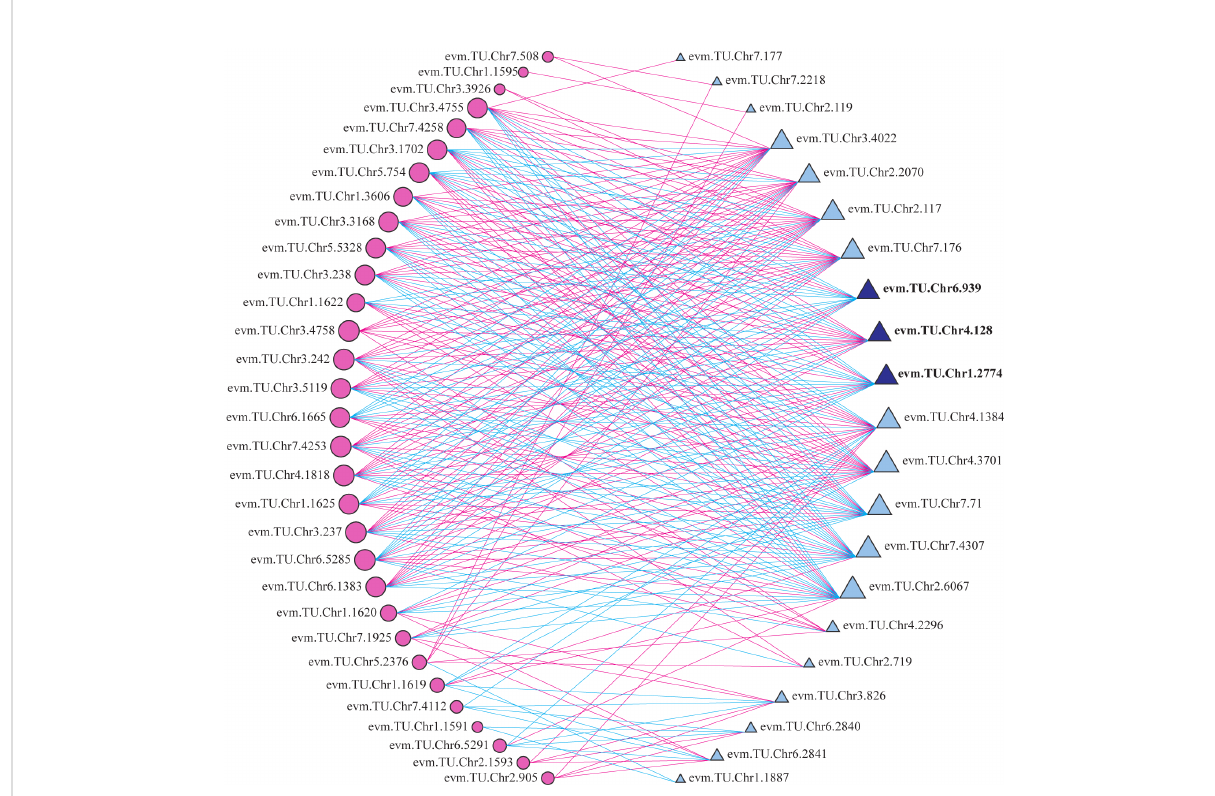
FIGURE 6 Correlation analysis of between differentially expressed TFs and structural genes. Circles colored in “ pink ” and triangles colored in “ blue ” mean structural genes and TFs respectively. Lines colored in “ red ” and “ blue ” represent positive and negative correlations,